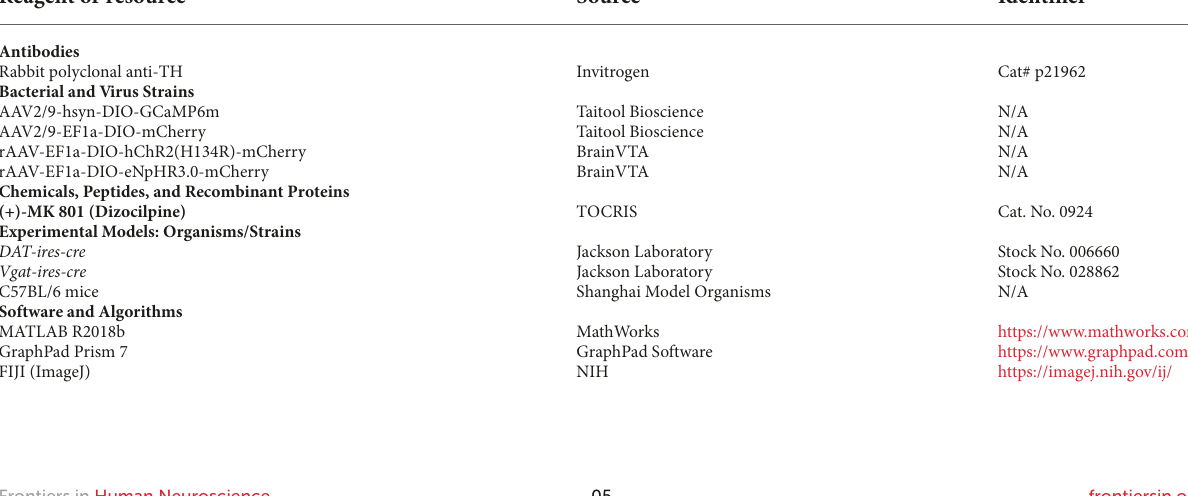
TABLE 1 Key resources table. Reagent or